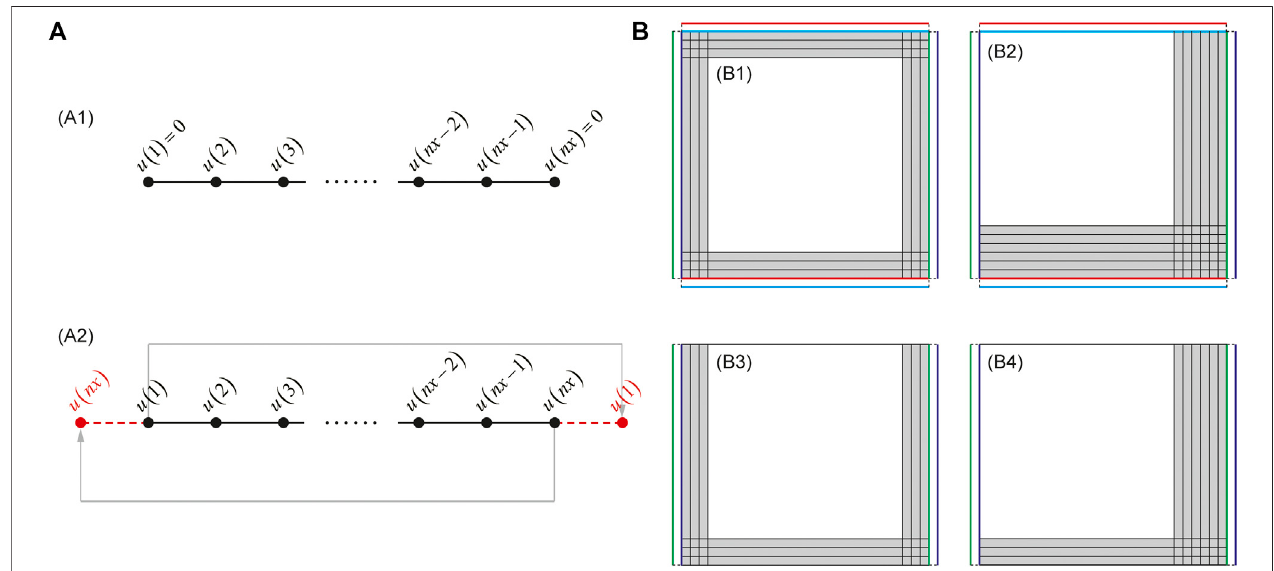
FIGURE 3 | Sketch map of the periodic boundary condition. (a1) The conventional aperiodic boundary condition for 1-dimensional model. (a2) The periodic boundary condition for 1-dimensional model. (B) Sketch map of the periodic boundary condition for 2-dimensional model. (b1) and (b2) are the sketch map of the periodic boundaries settled in the four directions of up, down, left, and right. (b3) and (b4) are the sketch map of the periodic boundary condition with the free boundary condition for the up boundary and the PML boundaries for the other three directions. periodic boundary is used only for the left and right boundaries.